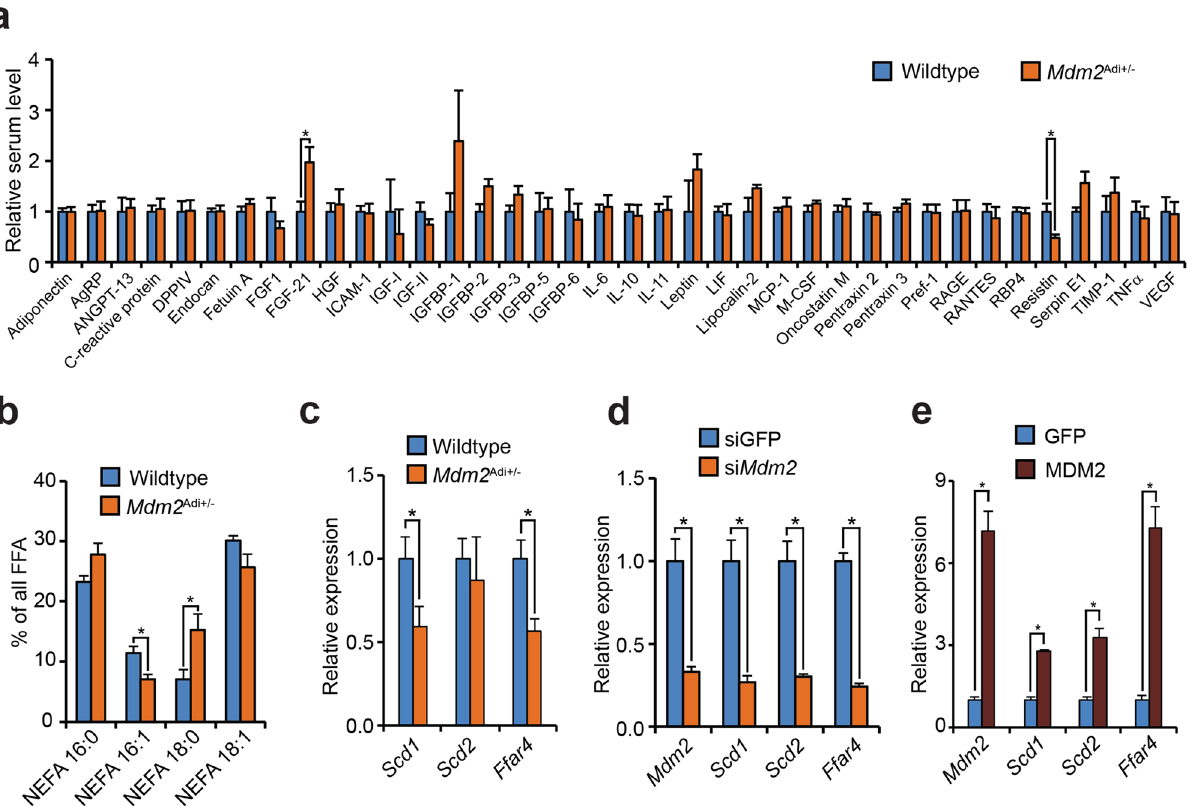
Figure 3. High-fat fed Mdm2 Adi+/− mice have disturbed adipokines secretion. ( a , b ) Serum from male wildtype (N = 4) and Mdm2 Adi+/− (N = 4) mice after 15 weeks on high-fat diet. ( a ) Relative circulating levels of 38 adipokines quantified with Adipokine Proteome Profiler Array. ( b ) Serum levels of NEFA 16:0 (free palmitic acid), NEFA 16:1 (palmitoleic acid), NEFA 18:0 (stearic acid) and NEFA 18:1 (oleic acid or vaccinic acid) quantified by mass spectrometry. ( c–e ) Real-time qPCR-based quantification of Scd1 , Scd2 and Ffar4 in ( c ) epiWAT of wildtype (N = 8) and Mdm2 Adi+/− (N = 7) mice after 15 weeks on high-fat diet, in ( d ) 3T3-L1 adipocytes with knockdown of Mdm2 , and in ( e ) 3T3-L1 adipocytes electroporated with plasmids expressing GFP or MDM2. Ffar4 , Free fatty acid receptor 4. For all panels, significance was tested using Student’s t -test, * = p -value <